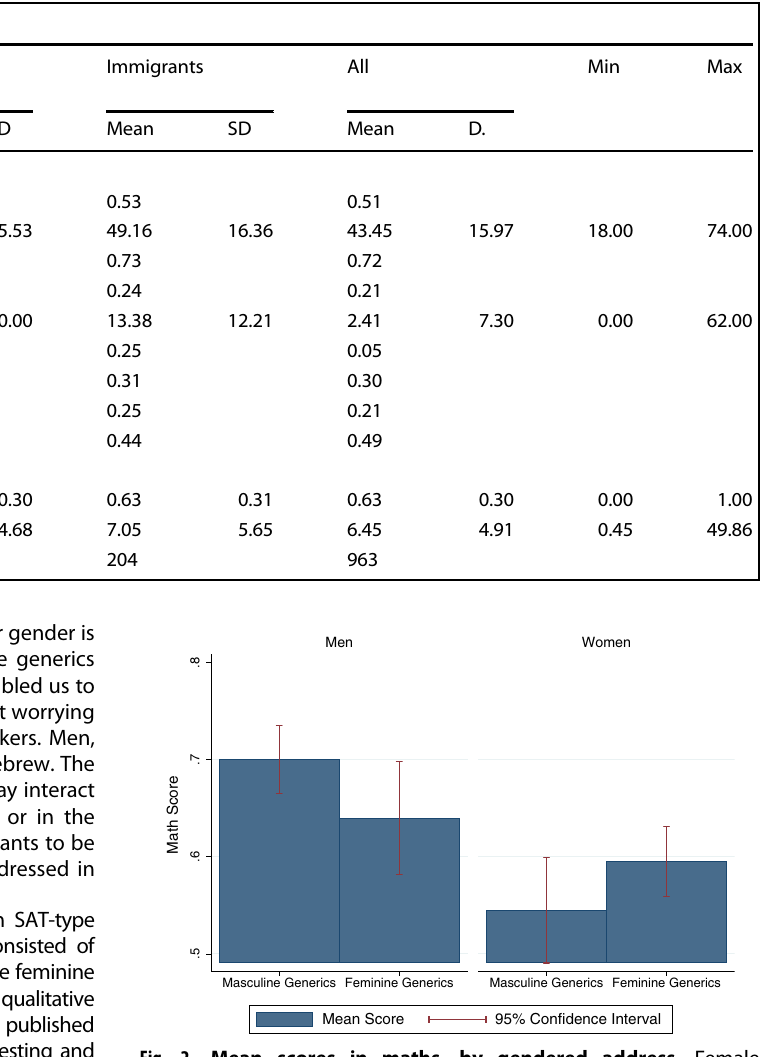
Fig. 2 Mean scores in maths, by gendered address. Female participants received higher scores when addressed in the feminine, compared to the masculine. Male participants received higher scores when addressed in the masculine, compared to the